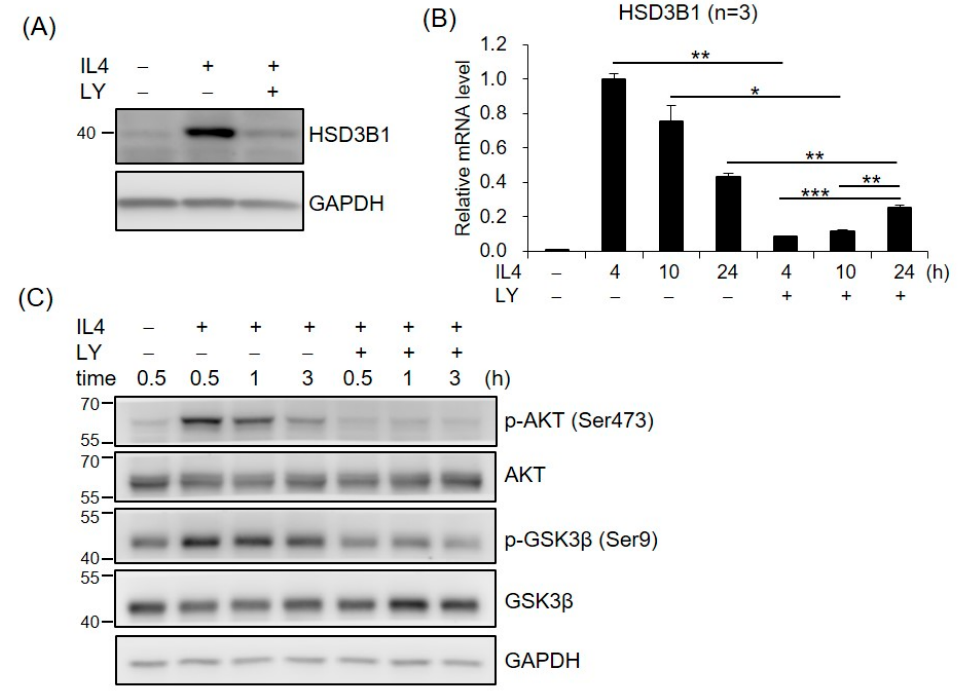
Figure 3. PI3K signaling is involved in IL4-induced HSD3B1 expression in HT-29 cells. The HT-29 cells were pretreated with PI3K inhibitor LY294002 (LY, 20 µ M) for 30 min and exposed to IL4 (20 ng/mL) for 24 h ( A ) or different time periods ( B , C ). ( A , C ) The cells were lysed and subject to immunoblotting using the indicated antibodies. GAPDH was used as the loading control. ( B ) RNA was extracted, and the HSD3B1 mRNA levels were quantified by RT-qPCR. The values are represented as the means ± SEM of three independent experiments; * p < 0.05, ** p < 0.01, *** p < 0.001.